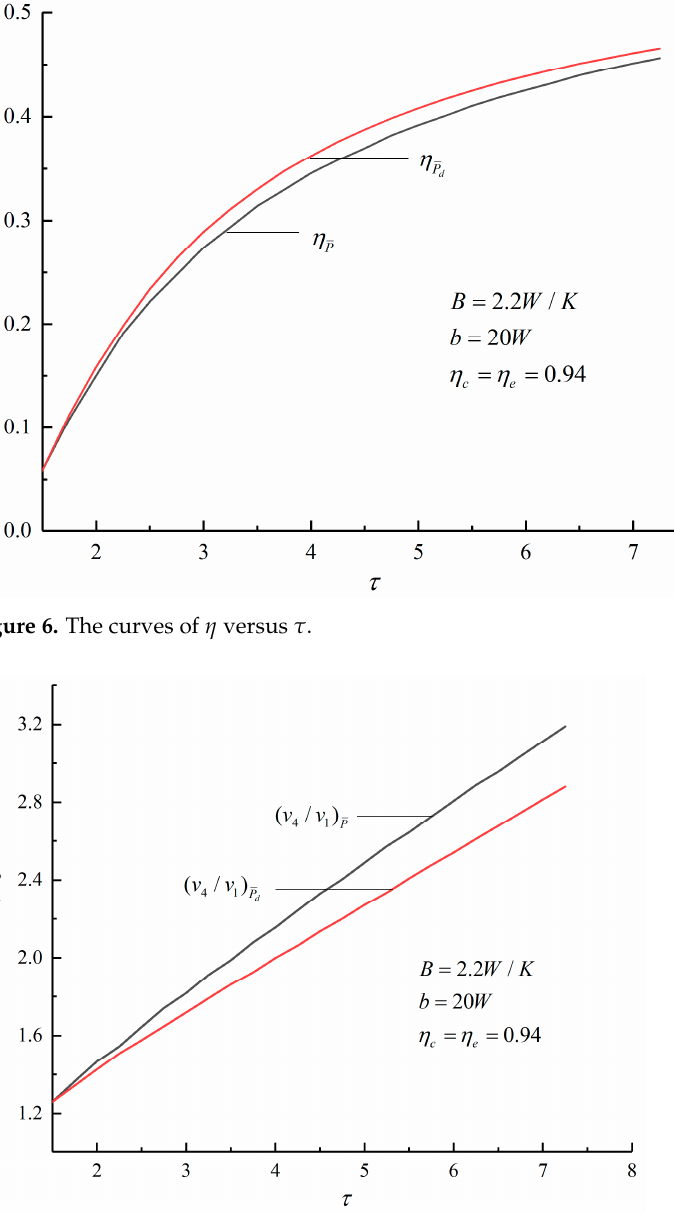
Figure 8. The curves of